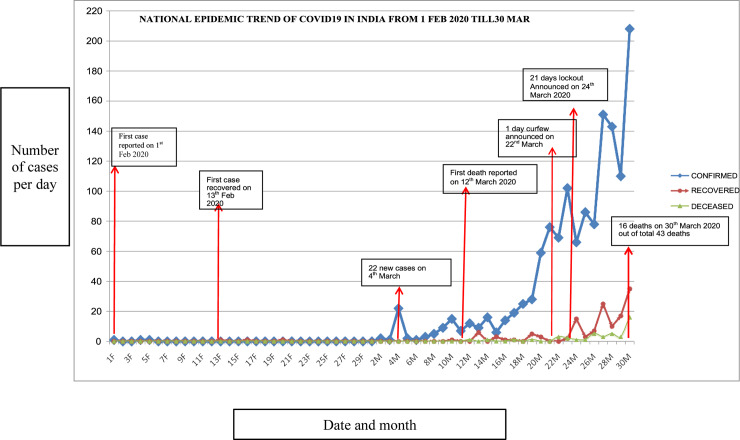
Timeline of events during the early phase of pandemic in India.(Source: https://www.mygov.in/covid-19).